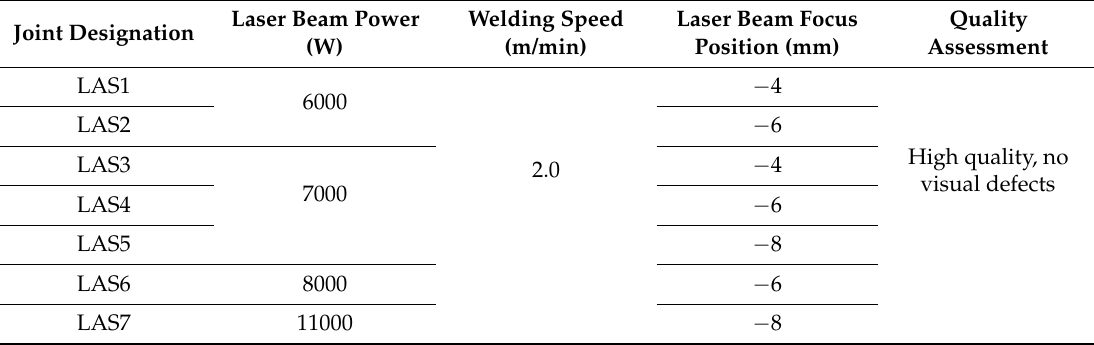
Table 2. Laser T-joint welding parameters of S700MC steel plates with a thickness of 10 mm. Remarks: gas shielding, argon; gas flow rate, 20 dm 3 /min; preheating drying temperature, 65 ◦ C.